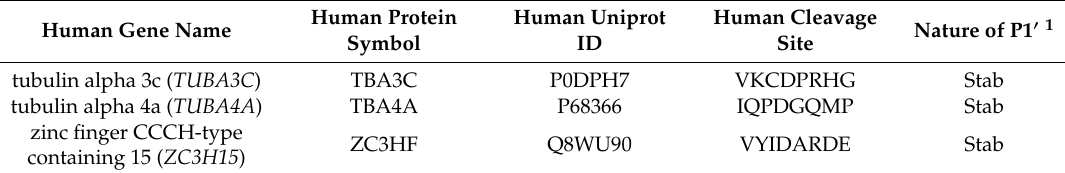
hydrophobicity of cleavage site surroundings and cleavage rates for human caspase targets, Figure S6: Distribution targets, Table S2: Description of orthologous caspase targets, Table S3: Percentage of P1 glutamate cleavage sites in species, Table S4: Summary of conservation criteria, for all human and orthologous targets, Table S5: Secondary structure predictions for human caspase targets, Table S6: Comparison of secondary structure prediction results with previous studies, Table S7: Percentage of P1 prime destabilizing amino acids according to the Arg / N-degron pathway, at the species level, Table S8: Subset of caspase targets most important in the apoptotic program.